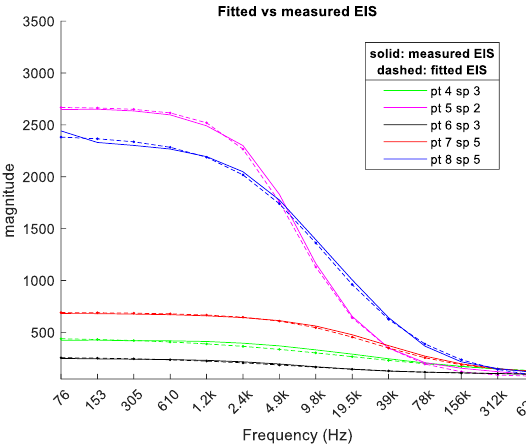
Fig.2: Comparison between measured and model fitted